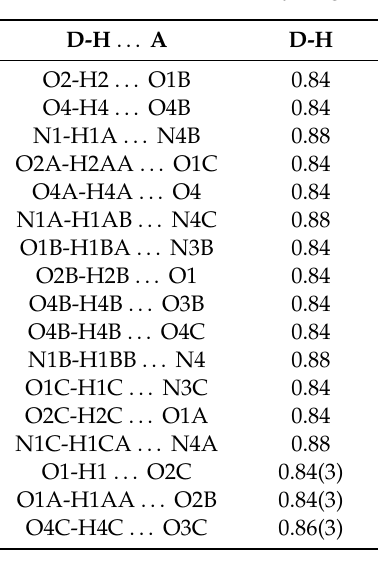
Figure 5. Two-dimensional hydrogen-bond networks formed by hydrogen-bond ring motifs. Table 2. Hydrogen-bond of TICA-II (Å, ◦